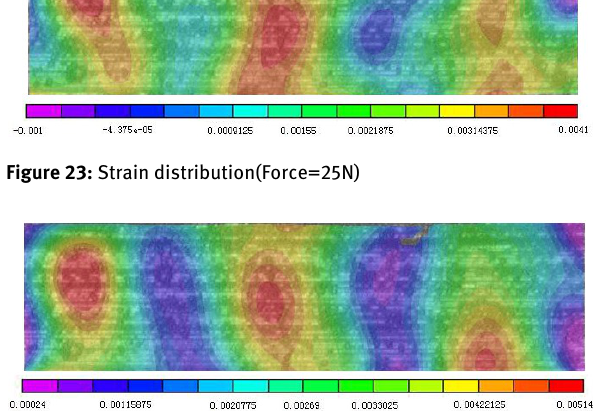
Figure 18: The strain-force curve of the C/SiC mini-composite